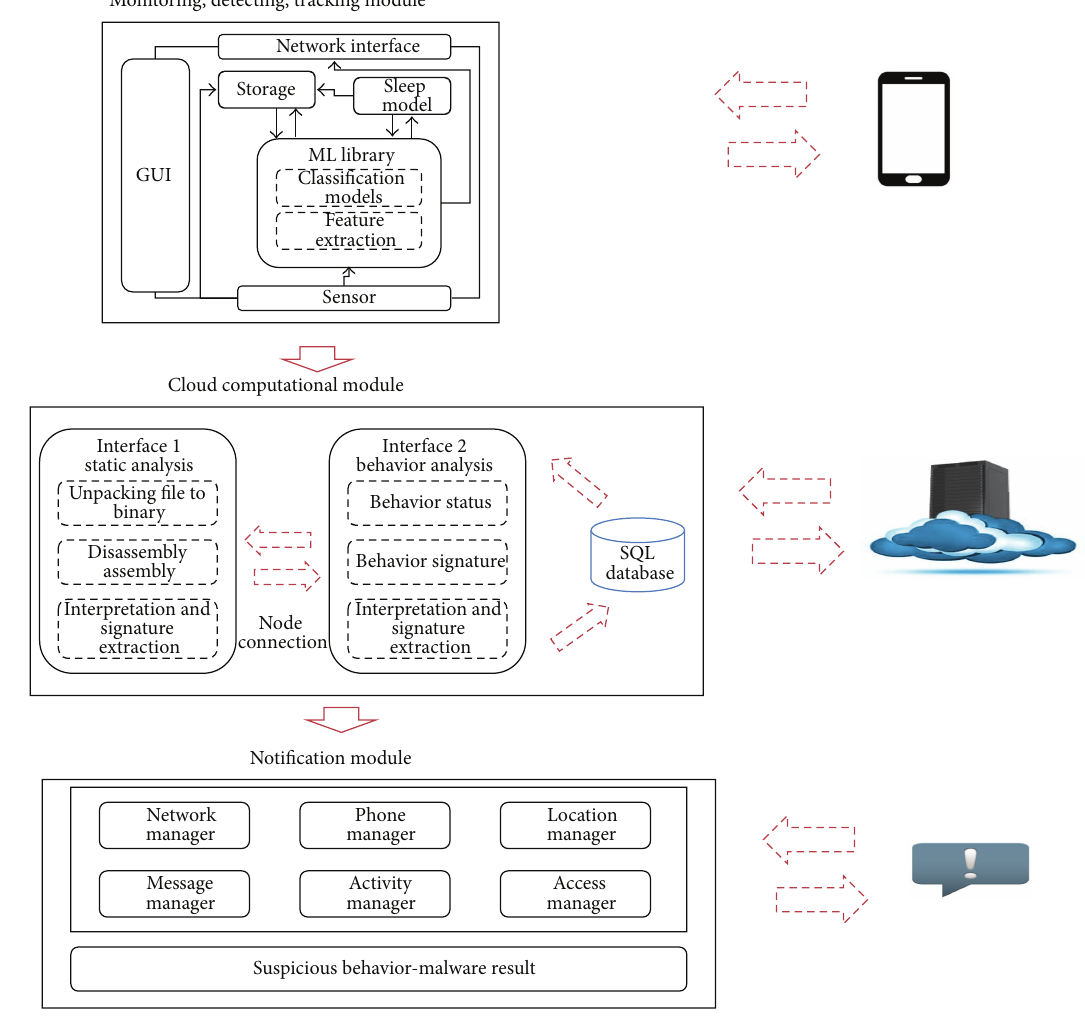
Figure 7: The MDTN system